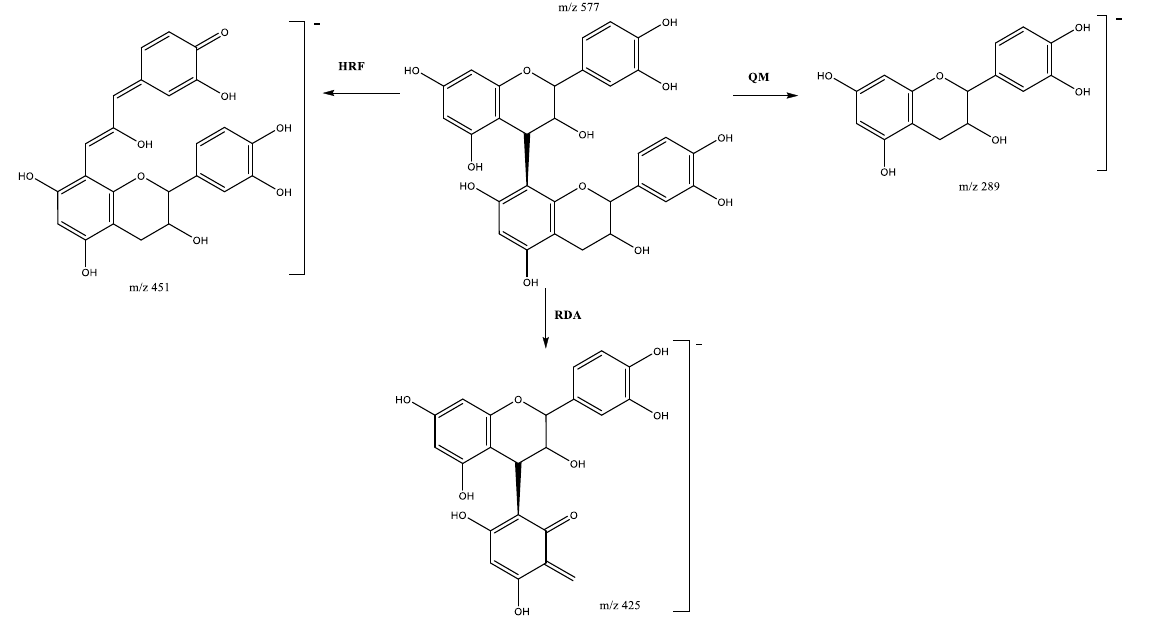
Figure 3. Fragmentation pathway of B-type procyanidin dimer showing the products formed by heterocyclic ring fusion (HRF), quinone methide (QM) and retro-Diels – Alder (RDA) reactions. Four propelargonidin dimers, formed by two (epi)-afzelechins subunits, are present in peaks 23 (Rt = 15.79 min), 25 (Rt = 16.18 min), 36 (Rt = 18.24 min) and 40 (Rt = 19.71 min), which show [M-H] − at m / z 545.1473 (C 30 H 25 O 10 ). The main fragments (Figure 4) at m / z 419 [M–H-126] − are due to the loss of ring A during the HRF fragmentation, and ions at m / z 273 and 271 come from the QM cleavage of the interflavan bond. The fragment at m / z 273 can also be produced through the RDA fragmentation pathway in both subunits [26].